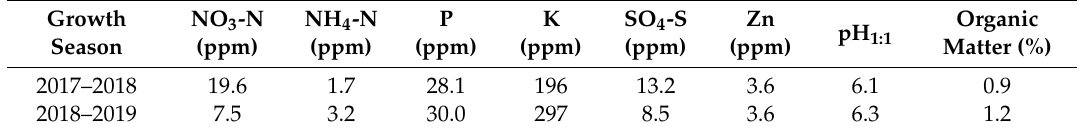
Table 1. Soil chemical properties in the two-year field trials at Hermiston, OR.